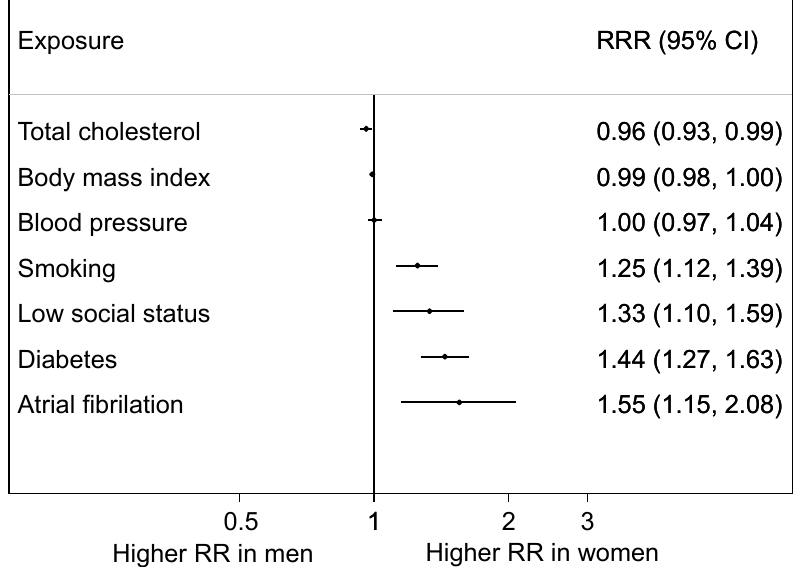
Figure 7. Women-to-men RRRs for stroke: pooled results from meta-analyses. Conventions as in Figure 6.